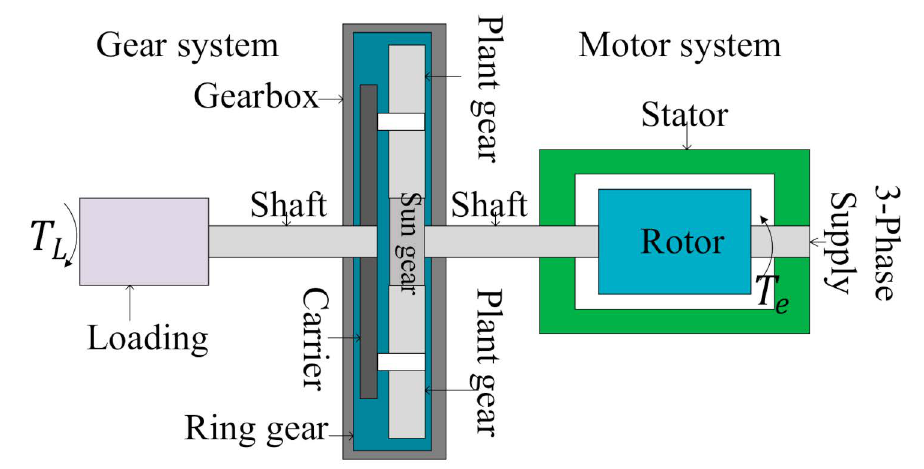
Figure 2. Motor-gear electromechanical